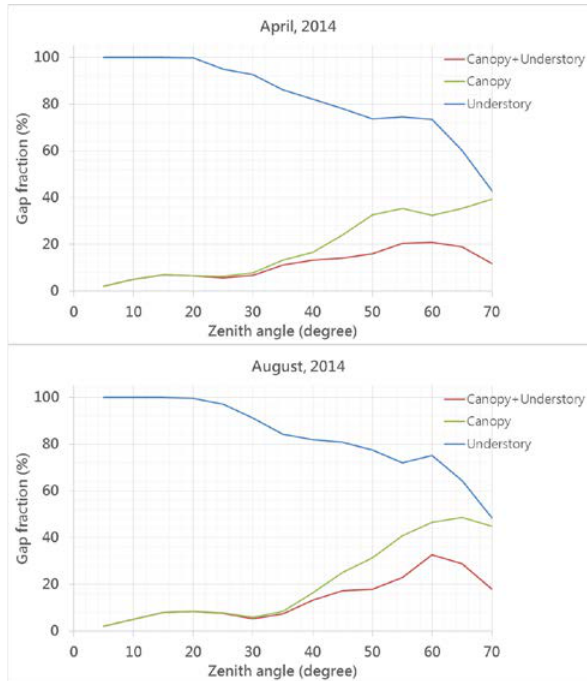
Figure 5. The gap fraction for (A) April and (B) August 2014